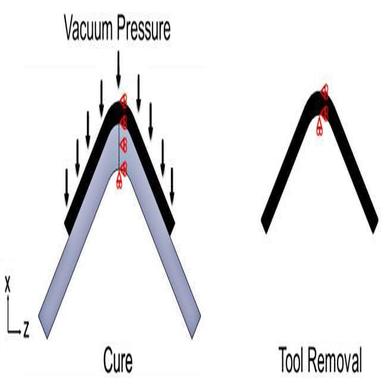
Boundary conditions for the stress-deformation simulation of the Lshape laminate for both the cure (left) and tool-removal (right) steps. (For interpretation of the references to colour in this figure legend, the reader is referred to the web version of this article.)